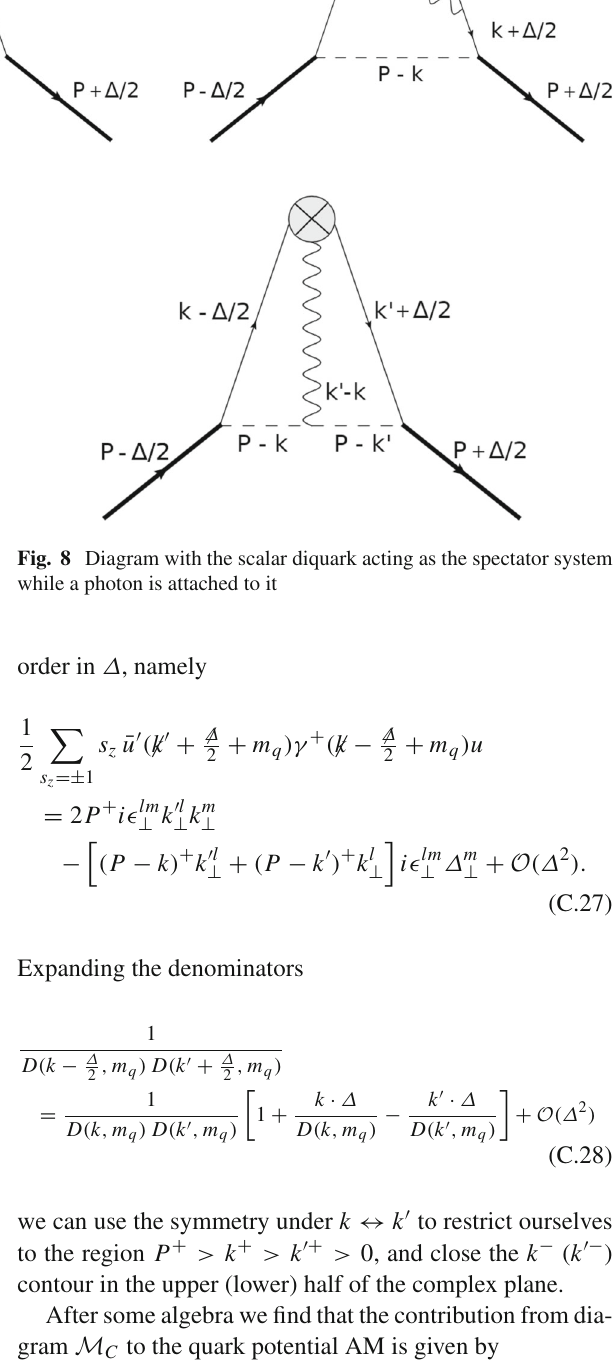
Fig. 7 Sum of the diagrams with a diquark acting as a spectator system while a photon is attached to either the incoming (left) or the outgoing (right) quark